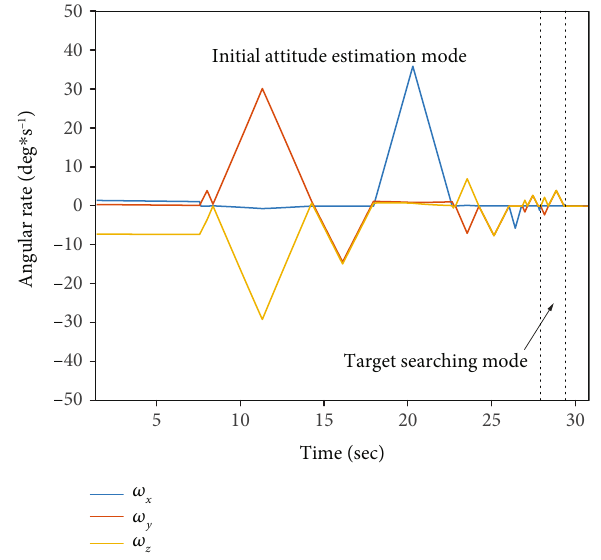
Figure 6: Time history of angular rate during initial attitude estimation mode and target searching